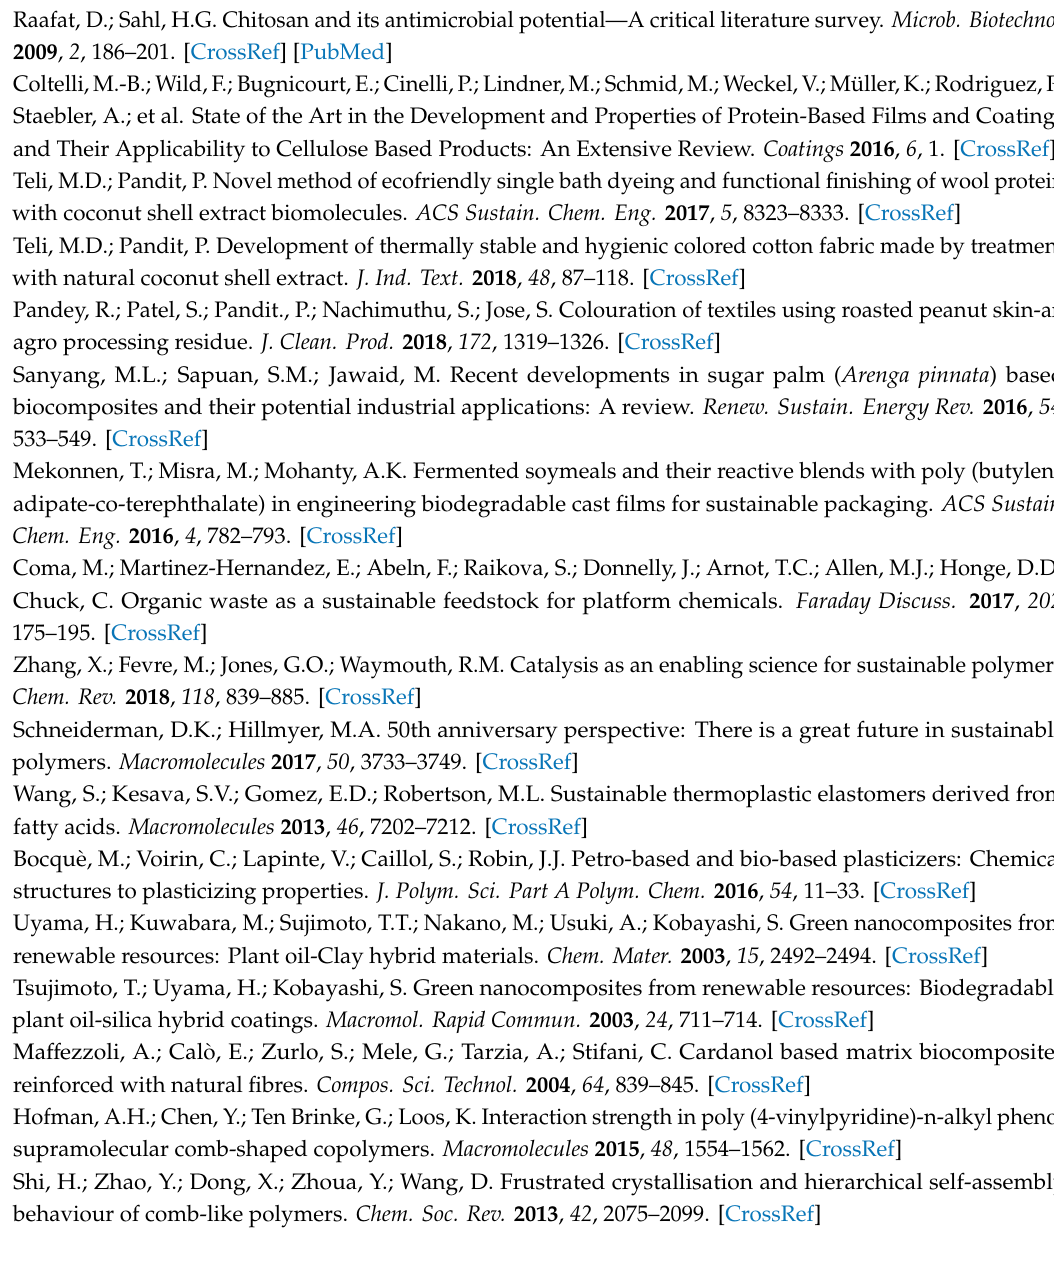
Figure S1: 1H NMR spectrum of PDPMA monomer. Figure S2: FT-IR spectrum of PDPMA monomer, Figure S3: Mass Spectrum of PDPMA